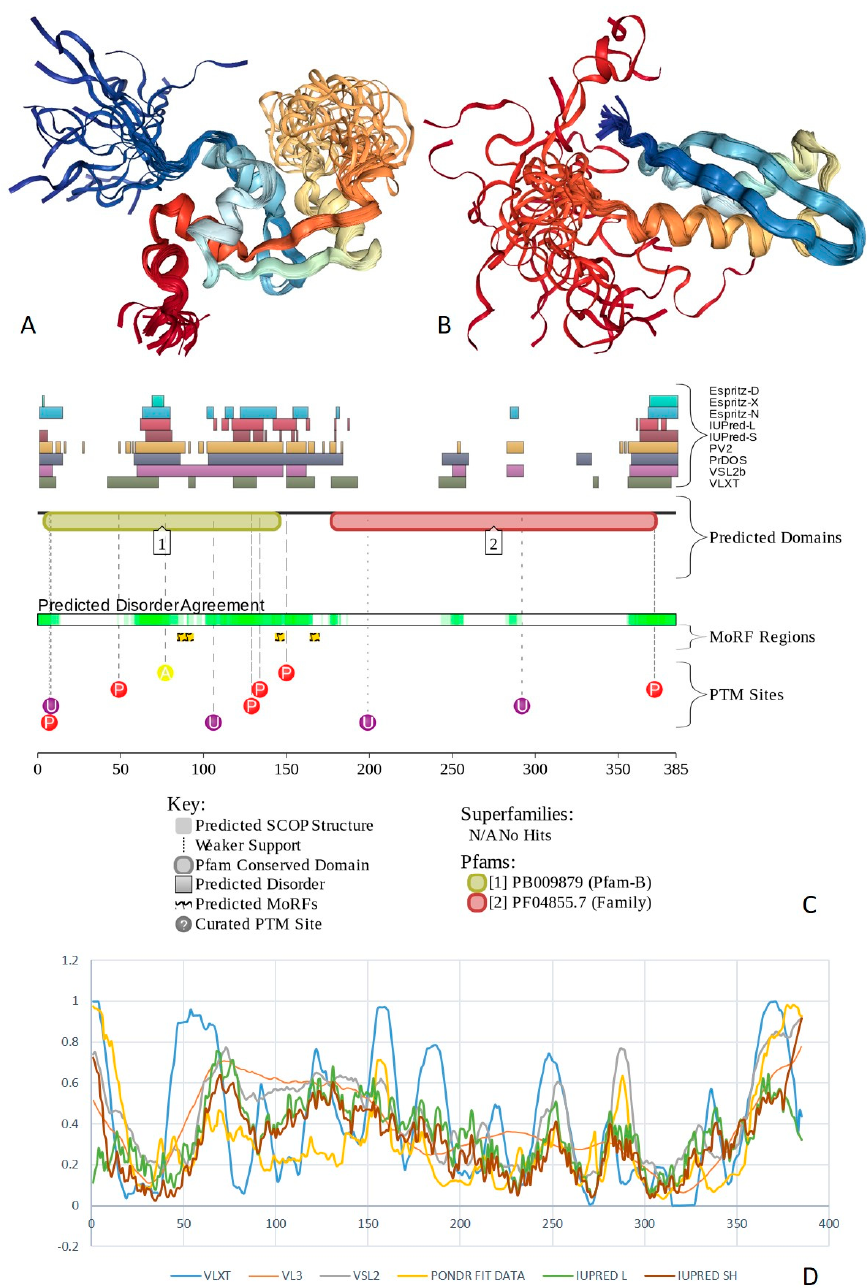
Figure 9. Structural organization of the human BAF47 protein. ( A ) NMR structure of the DNA-binding domain (residues 2–113, PDB ID: 5AJ1). ( B ) NMR solution structure of the MYC / HIV-1 integrase binding region (residues 183–265; PDB ID: 6AX5). ( C ) D 2 P 2 functional disorder profile of human BAF47 protein (UniProt ID: Q12824). ( D ) Intrinsic disorder profile of human BAF47 generated by six commonly used predictors of intrinsic disorder (PONDR ® VLXT, PONDR ® VL3, PONDR ® VSL2, PONDR ® FIT, IUPred_short, and